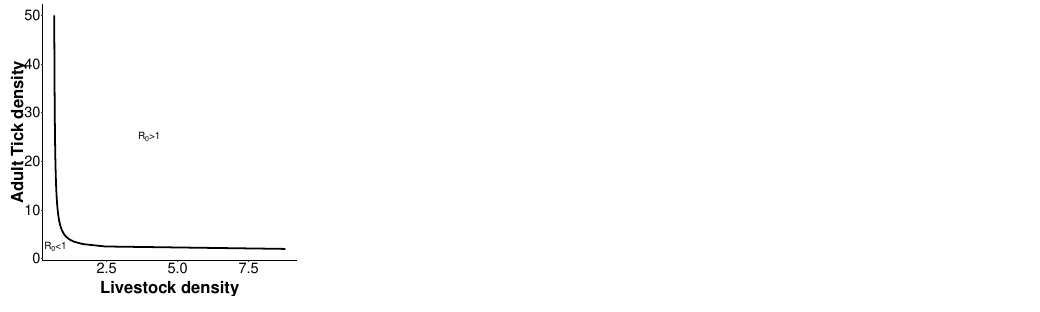
Figure 2. Relationship between tick density and livestock density in an area of predicted CCHF persistence. Parameters values are used from Table